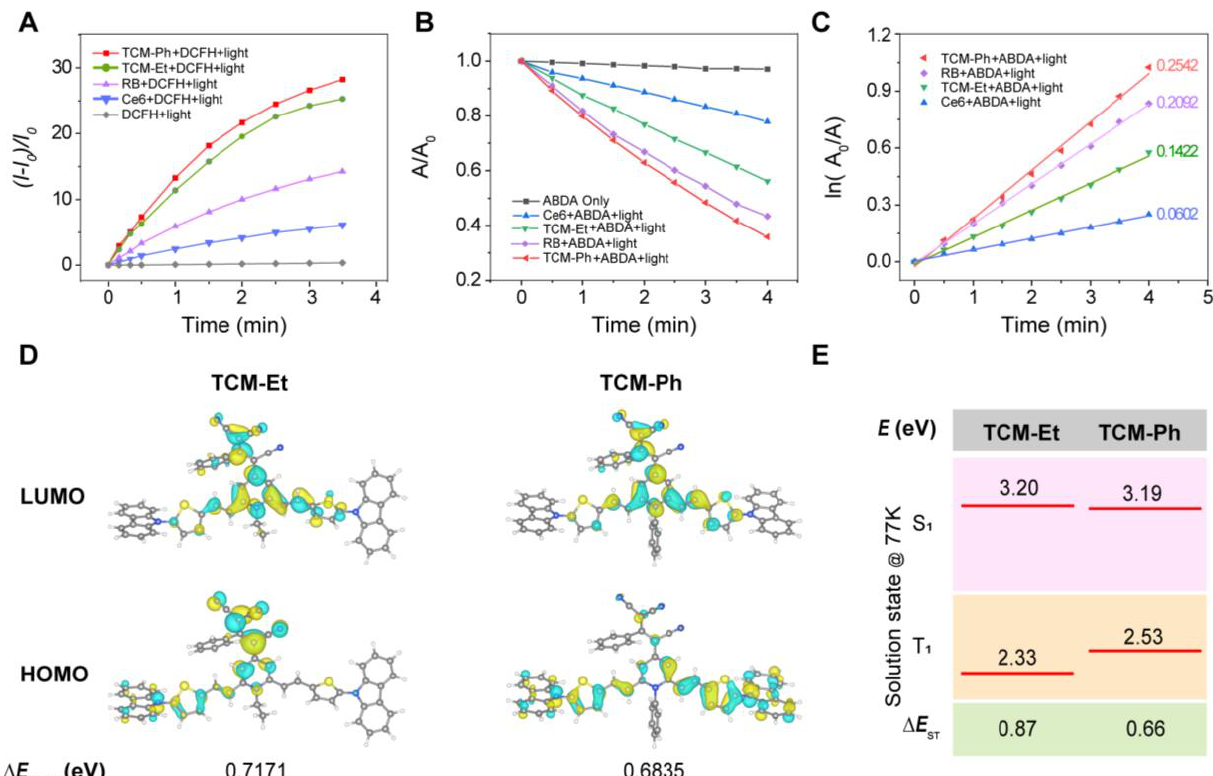
Figure 3. High ROS generation of TCM-Ph. ( A ) Light-induced total ROS generation of Ce6, RB, TCM-Et and TCM-Ph (10 µ M) with DCFH (40 µ M) as indicator. The plot of relative PL intensity ( I - I 0 )/ I 0 at 525 nm versus the different irradiation times, where I 0 is the fluorescence value of the mixture at 525 nm before illumination, and I is the fluorescence value of the mixture at 525 nm after illumination; excitation wavelength is 488 nm. ( B ) Light-induced 1 O 2 generation of Ce6, RB, TCM-Et and TCM-Ph (10 µ M), evaluated by ABDA (50 µ M). The relationship between A/A 0 of ABDA at 378 nm versus the different irradiation times. ( C ) The relationship between ln( A 0 /A ) and the light irradiation times, where A 0 is the absorbance of ABDA at 378 nm before light irradiation, and A is the absorbance of ABDA at 378 nm after light irradiation. ( D ) Molecular orbital amplitude plots of HOMO and LUMO. ( E ) The energy levels of TCM-Et and TCM-Ph. The well vibration-resolved profiles allow accurate energy level abstractions based on the 0–0 peaks for solution samples in 2-methyl-tetrahydrofuran at 77